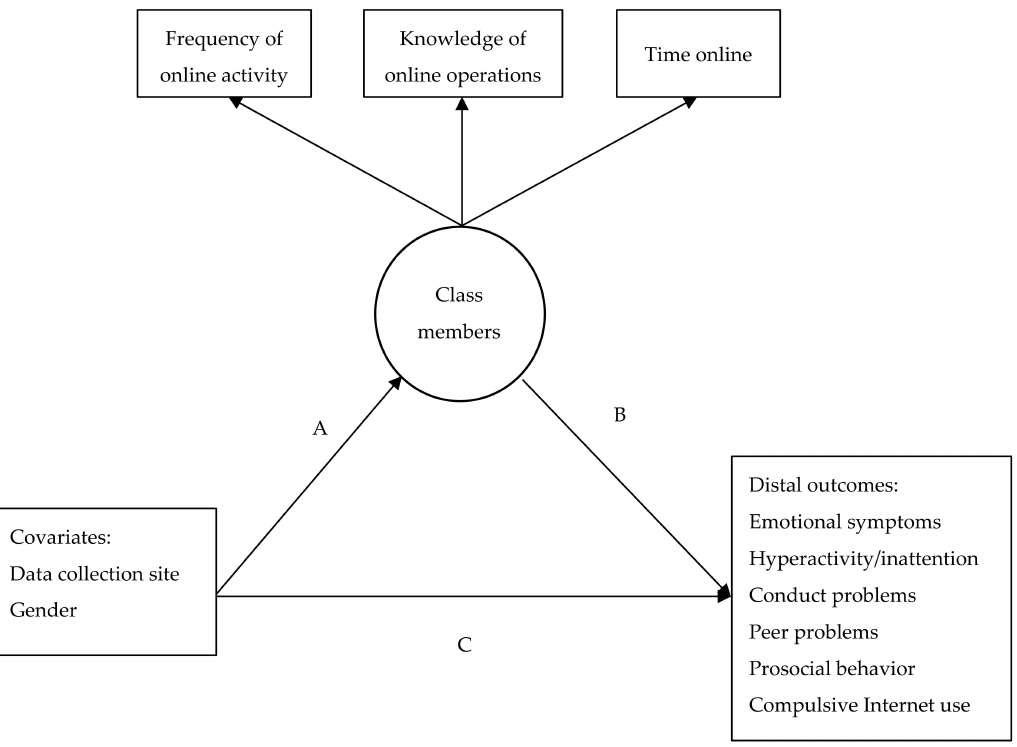
Figure 1. Conceptual model of the latent classes of children’s Internet use with the covariates and outcomes. Note: A—path from covariates to latent classes; B—path from latent classes to distal outcomes; C—path from covariates to distal